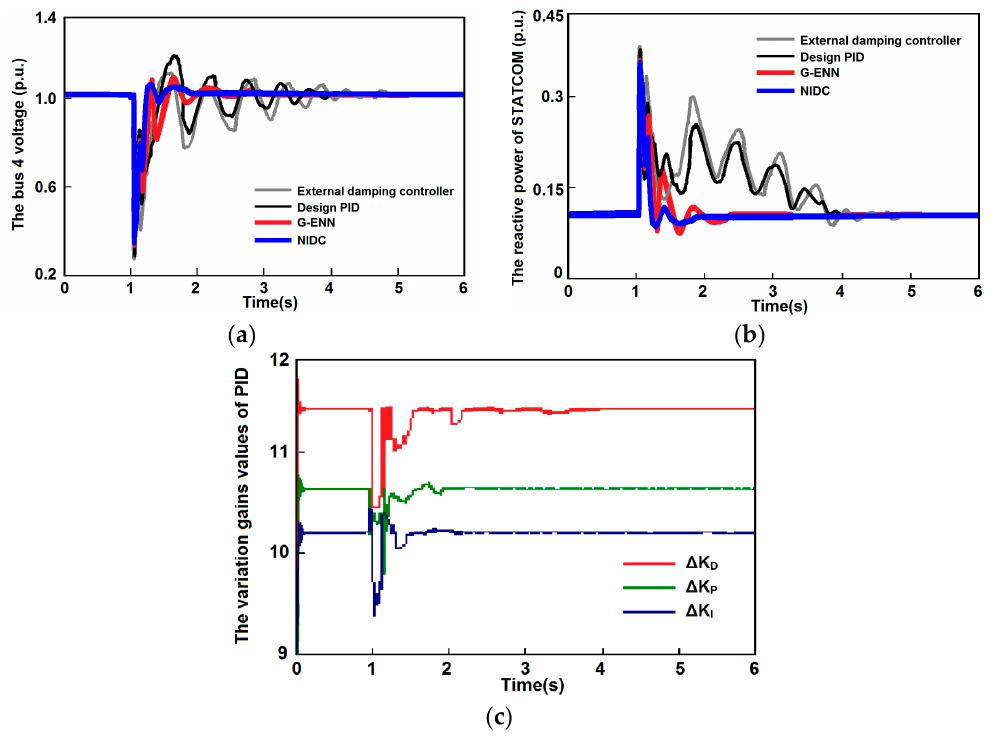
Figure 9. The responses of voltage, STATCOM and the variation PID parameters in Case 1 ( a ) The voltage of bus 4; ( b ) The reactive power of the STATCOM; ( c ) The variation PID parameters.